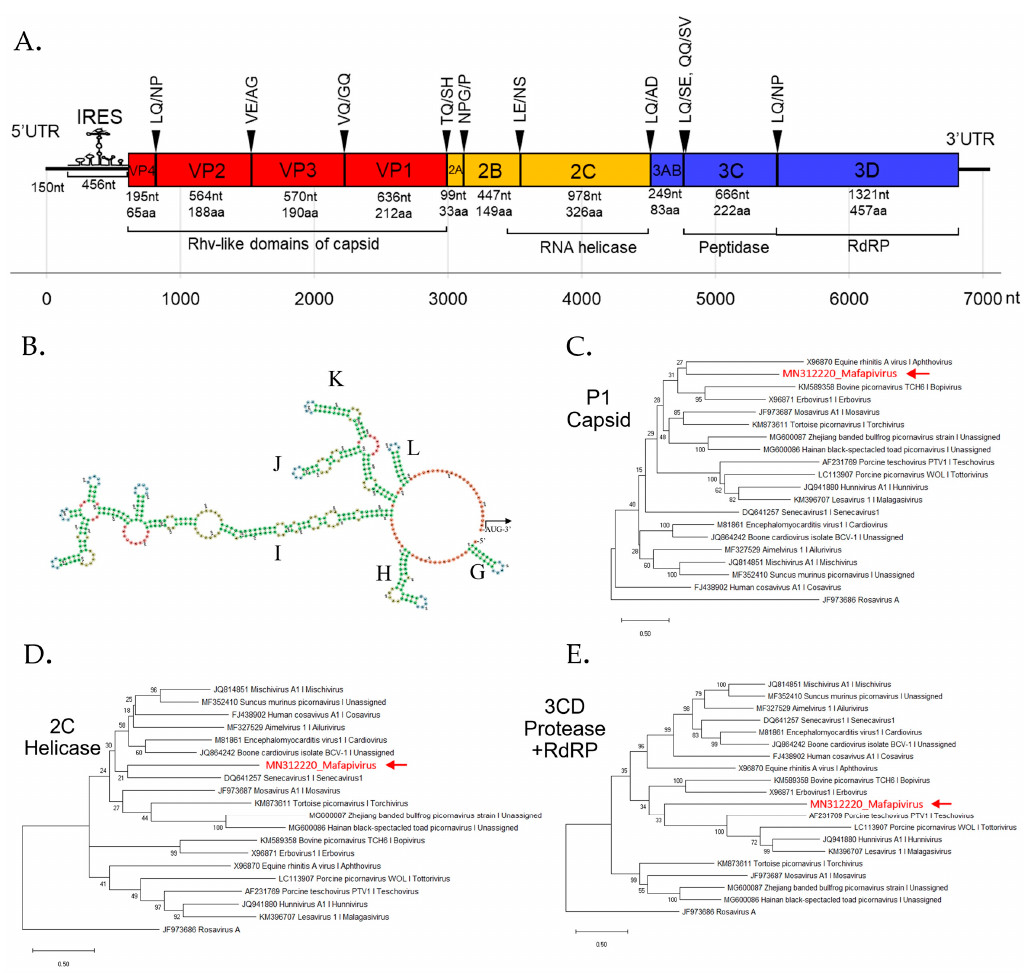
Figure 3. ( A ) Schematic genome organization of novel picornavirus ( Macaca fascicularis picornavirus 1 or Mafapivirus 1 ) identified from captive cynomolgus macaque (LMF17) indicating the cleavage sites and protein domains. ( B ) The predicted internal ribosome entry site (IRES) hybridization structure predicted by mfold software shows that this virus contains Type II IRES recognized by the conserved structure of Y-shaped J–K domains. Colors of the structure indicate the secondary structure in predicted IRES; Green: Stems (canonical helices), red: Multiloops (junctions), yellow: Interior loops, blue: hairpin loops, and orange: 5’ and 3’ unpaired region. The phylogenetic trees of Mafapivirus 1 were plotted for ( C ) P1 region, ( D ) 2C region, and ( E ) 3CD region. The tree was drawn to scale, with branch lengths measured in the number of changes per amino acid site. Nodes in the tree represent % of bootstrapping value (1000 rounds).